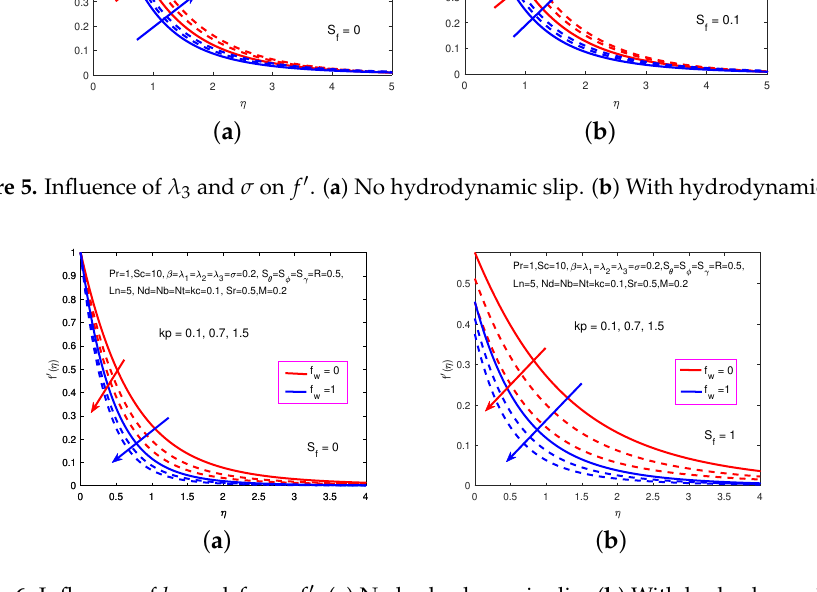
Figure 6. Influence of kp and f w on f (cid:48) . ( a ) No hydrodynamic slip. ( b ) With hydrodynamic slip.